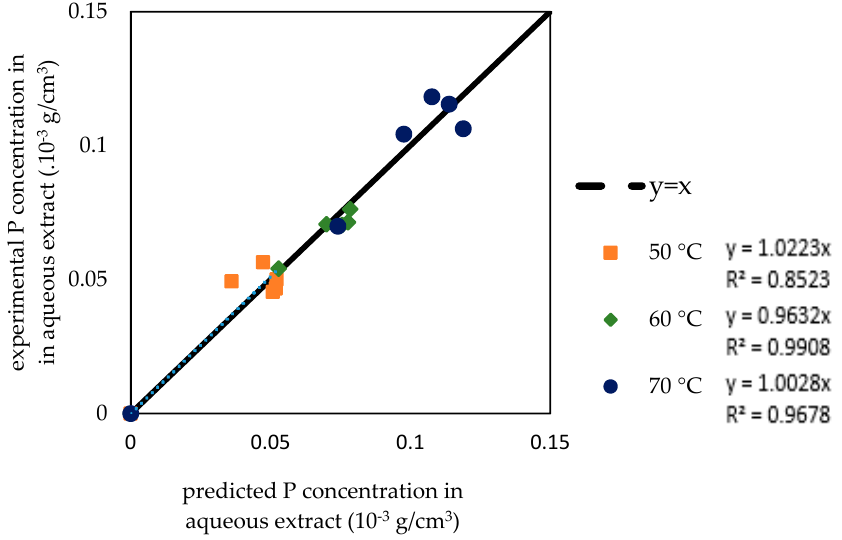
Figure 10. The correlation of the predicted and experimental P concentration in aqueous extract.